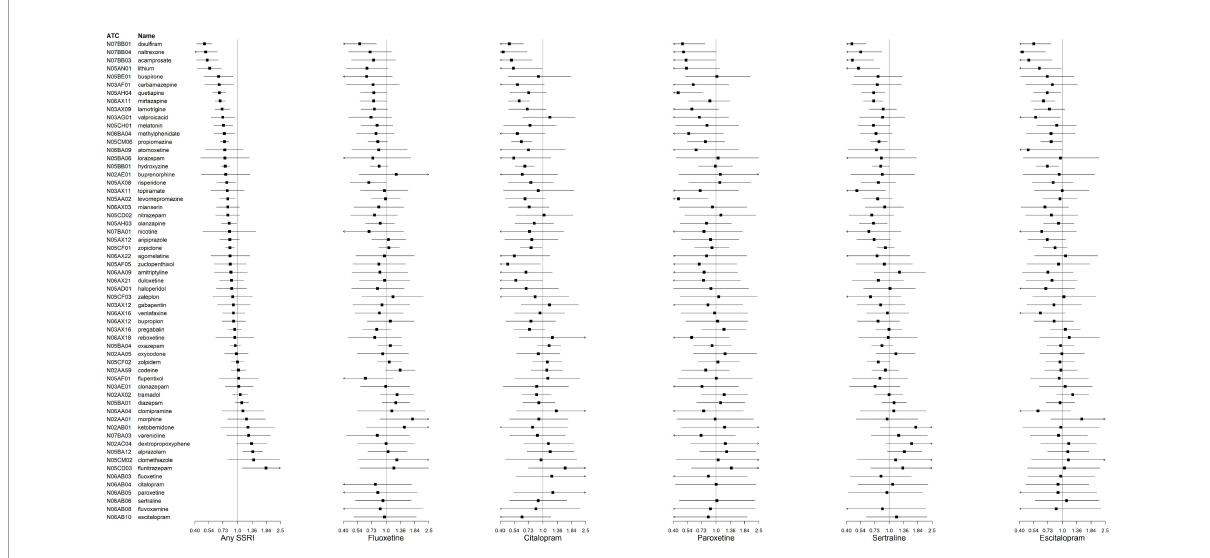
FIGURE3 Incidence rate ratios (IRRs) and credible intervals of suicidal behavior associated with central nervous system (CNS) drug initiation during treatment with specific selective serotonin reuptake inhibitors (SSRIs). N02AA59 represents codeine combinations excluding